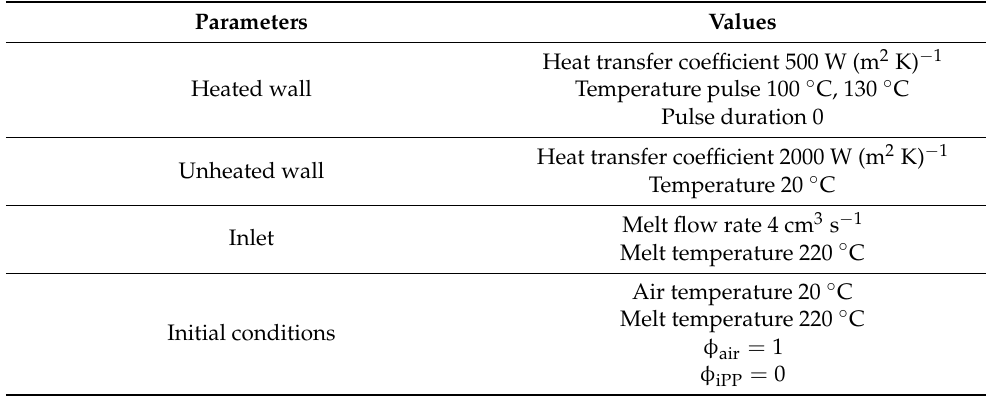
Table 4. Boundary conditions adopted for the injection molding